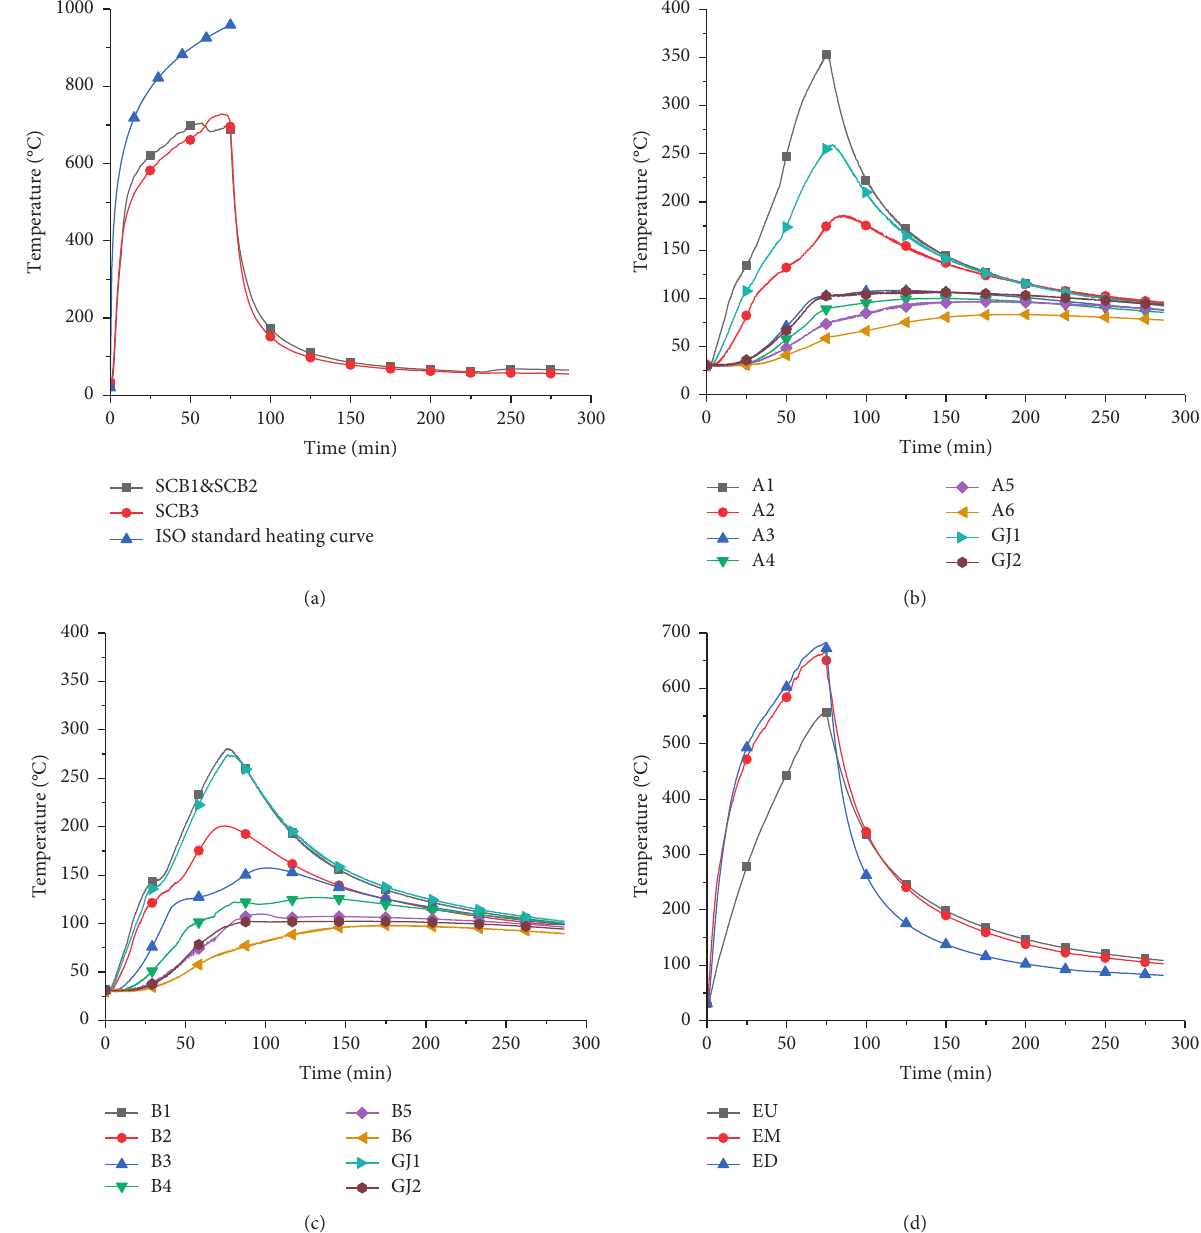
Figure 9: Temperature field analysis of SCB-2: (a) comparison of temperature curves, (b) temperature changes at position A, (c) tem- perature changes at position B, and (d) temperature changes of the steel beam.